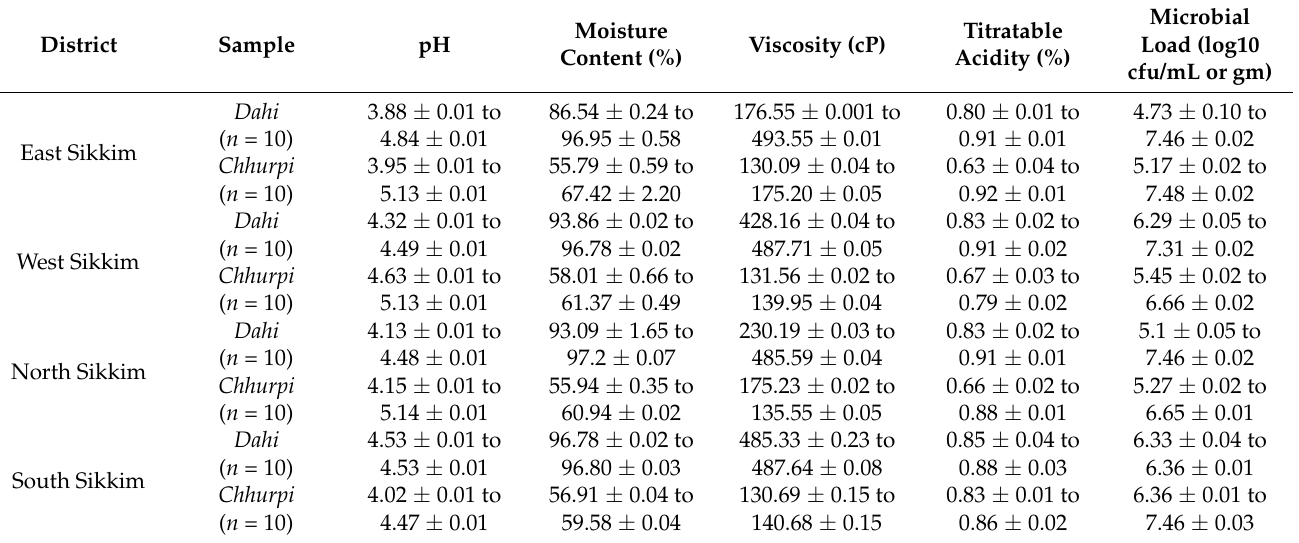
Table 2. Product characteristics, pH, moisture content, viscosity, titratable acidity and microbial load of dahi and chhurpi